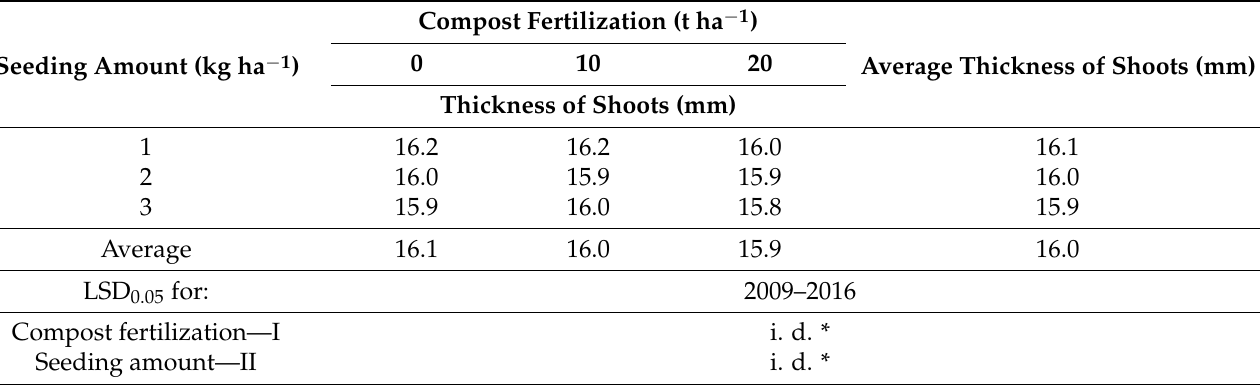
Table 6. Effects of seeding amount and fertilization with compost on the average thickness of the Sida shoots (mm) during the years of full use